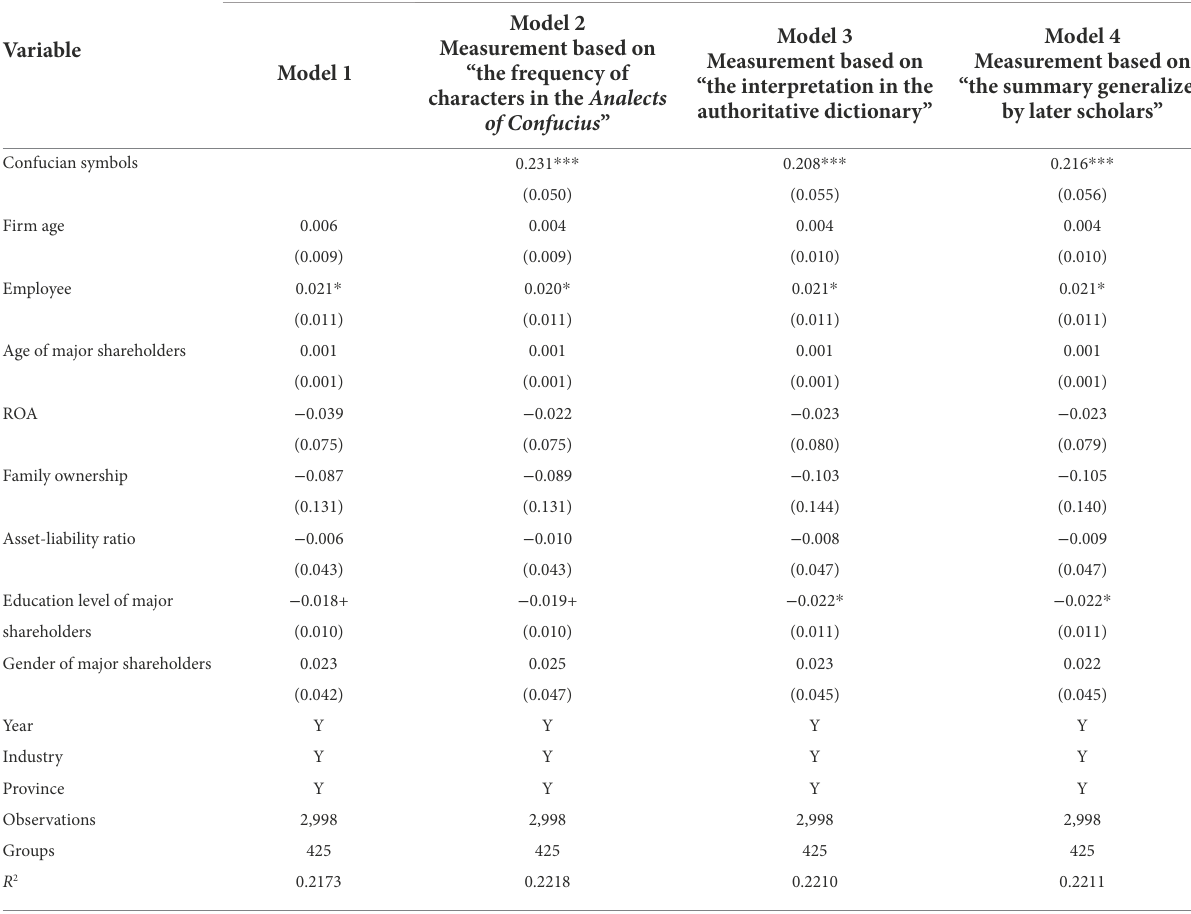
TABLE 4 The effect of Confucian symbols on external supervision